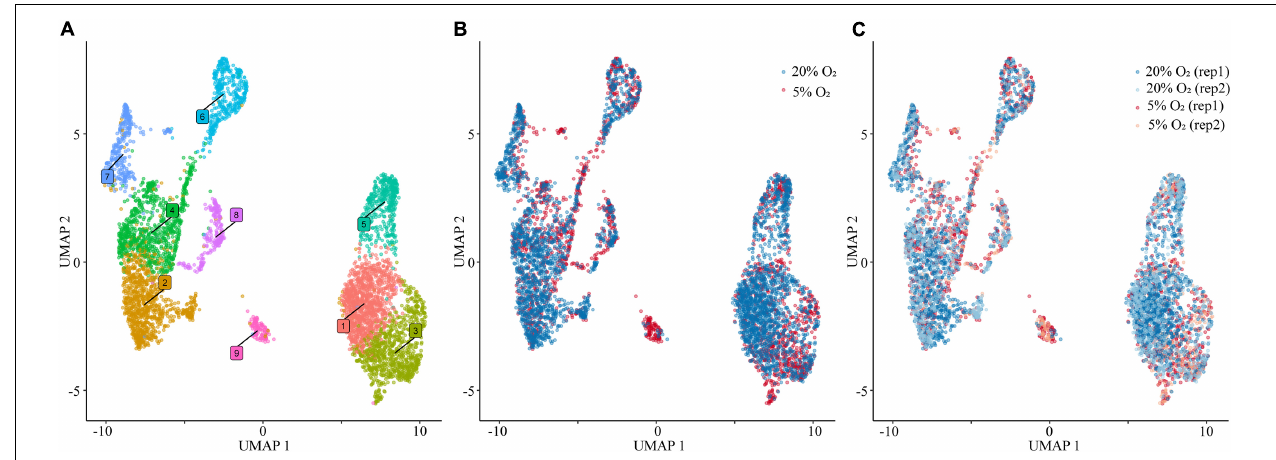
FIGURE 1 | Single nuclear RNA sequencing. (A) Visualization of nuclei included in the analysis, colored according to assignment by clustering analysis. (B) Plot of the nuclei obtained from the cells cultured under 20% O 2 (blue) and 5% O 2 (red) concentration conditions. (C) Nuclei plot obtained from each replicate of cells cultured under 20% O 2 (blue) and 5% O 2 (red) conditions. For all panels: 5,355 total nuclei were plotted in two dimensions based on transcriptome similarity using uniform manifold approximation and projection (UMAP) for all of the analyses using Seurat. Each dot represents an individual nuclei. 20% O 2 , nuclei obtained from the cells cultured under 20% O 2 ; 5% O 2 , nuclei obtained from the cells cultured under 5% O 2 ; rep, replicate.